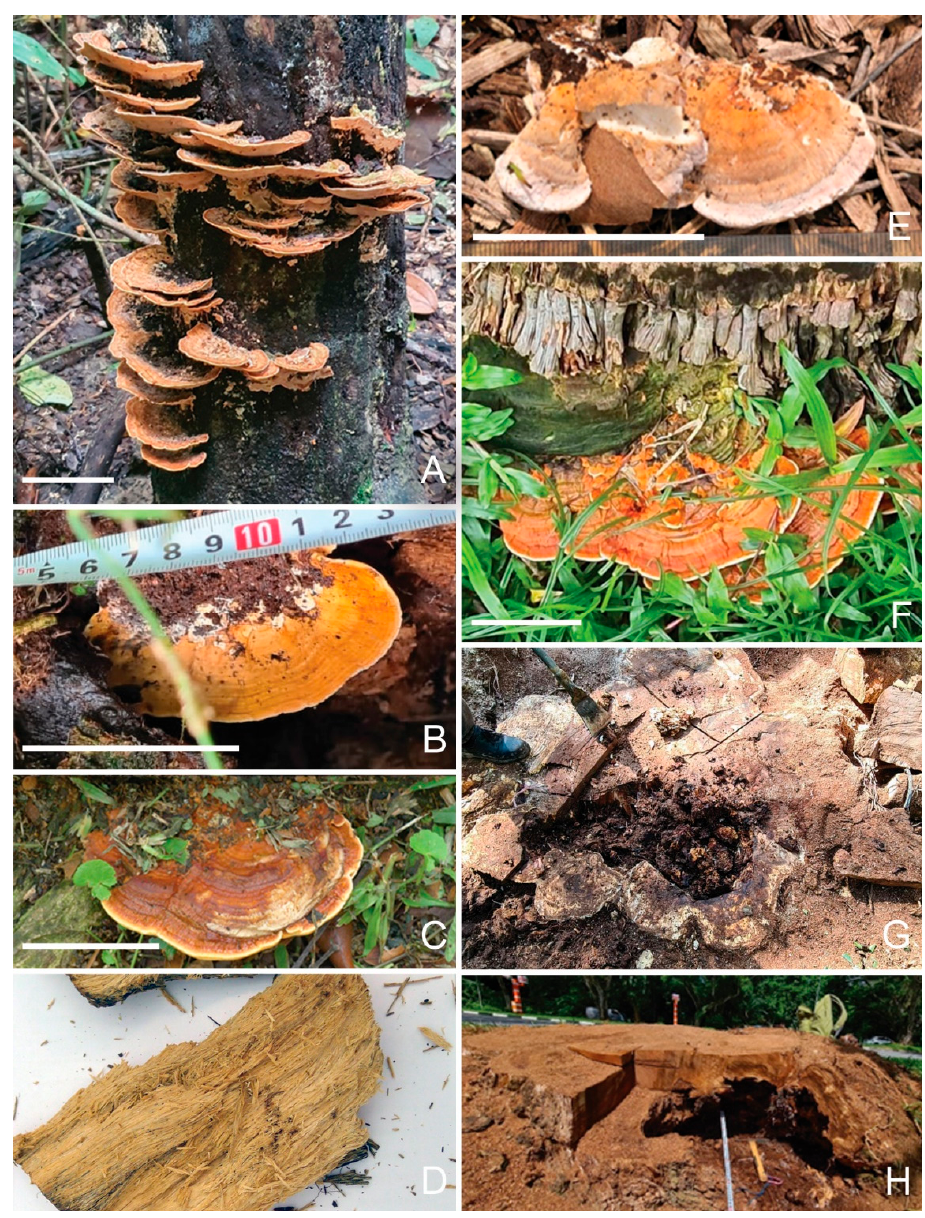
Figure 1. Rigidoporus microporus detected in Singapore urban trees. ( A ): a tree log with R. microporus fruiting bodies (L132); ( B , C ): a fruiting body at the base of a decayed Rain Tree (R16, R66); ( D ): a piece of decayed wood from a Rain Tree (R70) infected by R. microporus ; ( E ): a similar-looking fruiting body of Meripilus giganteus (A164FB3); ( F ): a palm stump (P175) with R. microporus fruiting body; ( G ): a